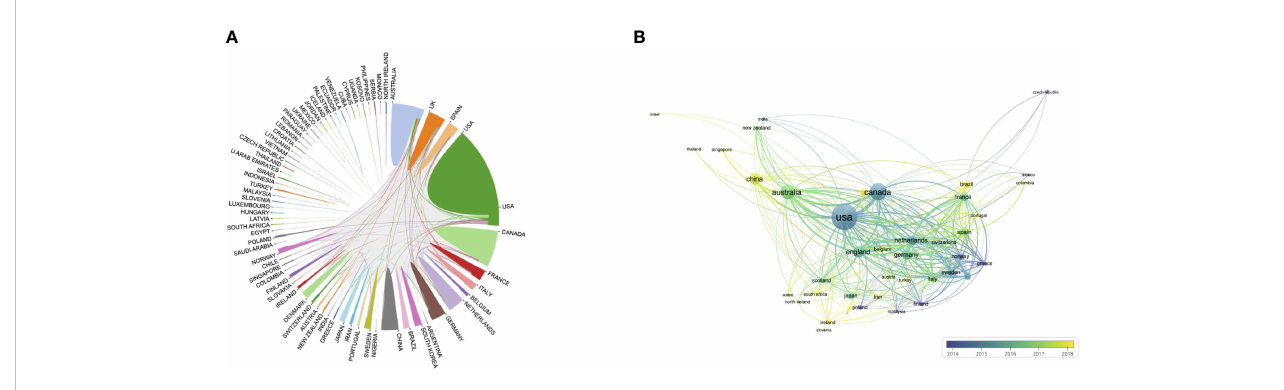
FIGURE 3 Distribution of countries associated with SB, PA, and cancer. (A) International collaboration between countries/regions (B) Temporal trend of country/ region